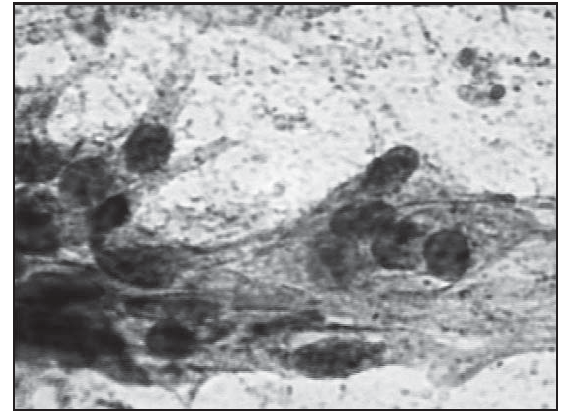
Figura 2 – Neste campo, núcleos com cromatina distribuída irregularmente e macronuc- léolos proeminentes sugerem a possibilidade de invasão (Papanicolaou, 400x)